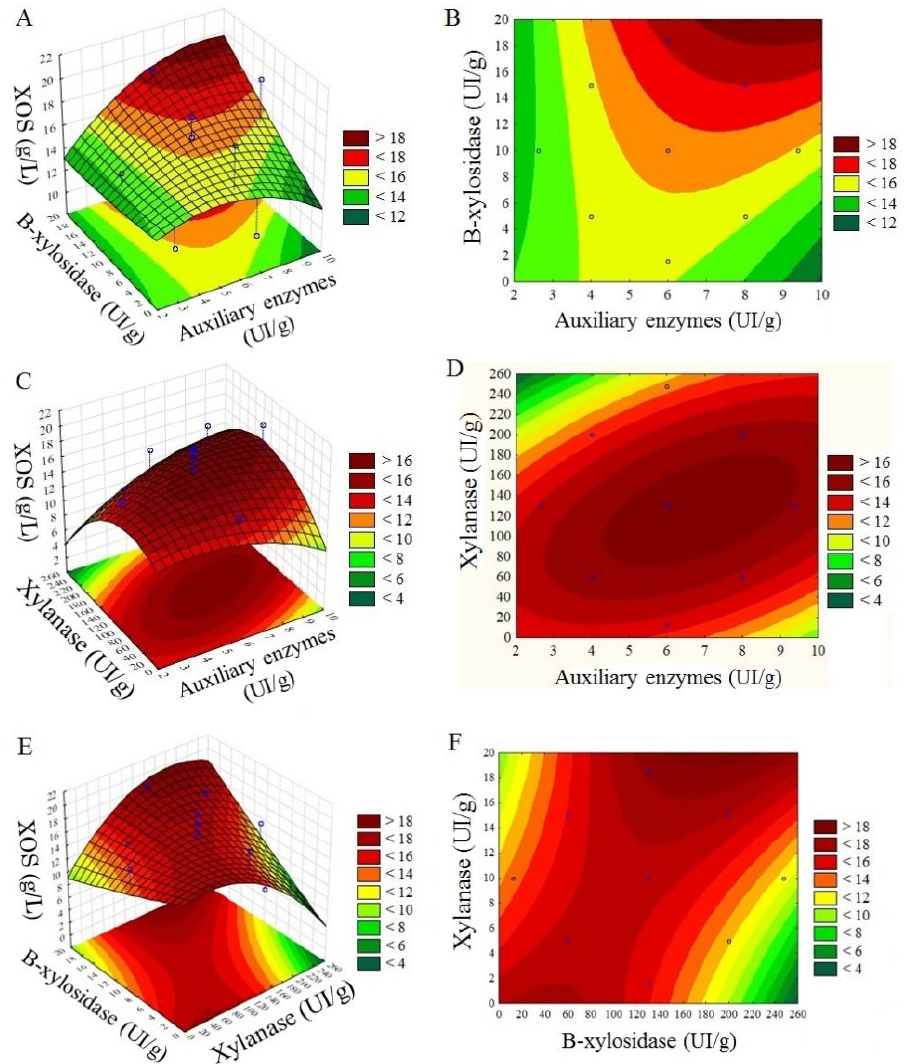
Figure 3. Response surface of xylooligosaccharides yield (%) and concentration (g/L) with xylanase (IU/g) and auxiliary enzymes (IU/g) variables. ( A , B ) Xylooligosaccharides yield (%) with xylanase (IU/g) and auxiliary enzymes (IU/g) variables; ( C , D ) xylooligosaccharides concentration (g/L) with xylanase (IU/g) and auxiliary enzymes (IU/g) variables; ( E , F ) xylooligosaccharides concentration (g/L) with xylanase (IU/g) and β -xylosidase (IU/g). The maximum xylanase load (92.4 IU/g) generated a yield of 81.2% XOS and a con- centration of 16.2 g/L, while the lowest xylanase load (7.5 IU/g) generated a yield and an XOS concentration equivalent to 80.3% and 16 g/L, respectively. For accessory enzymes, the maximum load (11.6 IU/g) generated a yield of 68.3% and a concentration of 13.6 g/L of XOS, while the lower load (0.3 IU/g) presented a yield and concentration of XOS equivalent to 80.6% and 16.1 g/L of XOS.